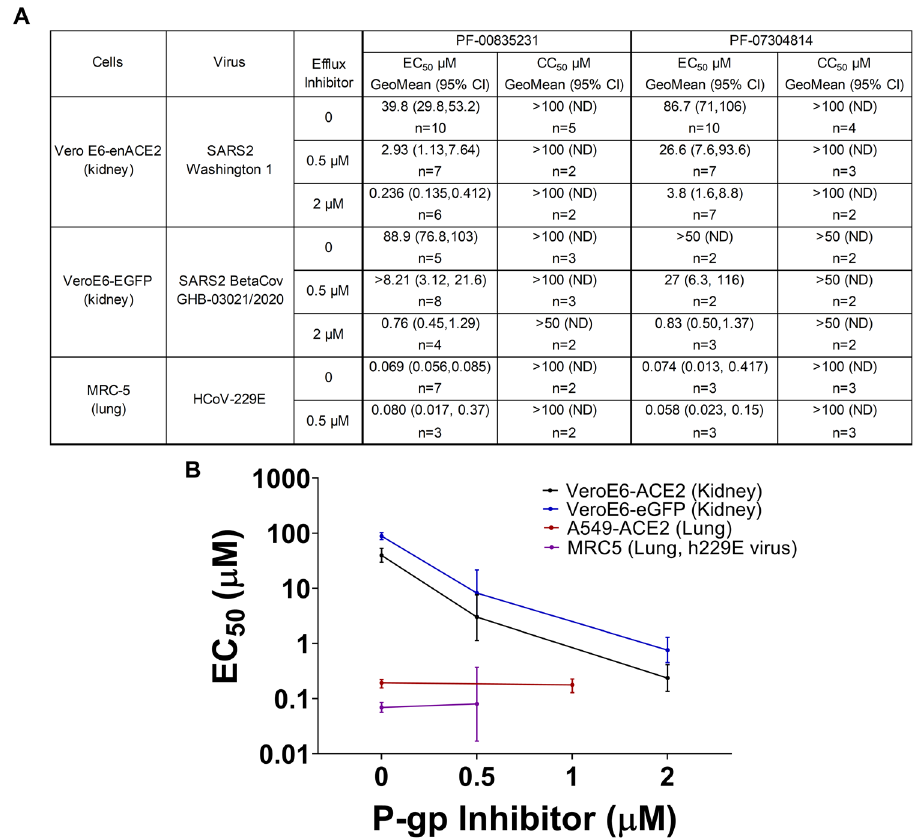
Fig. 2 Antiviral activity across cell lines and viruses. A In vitro antiviral activity (EC 50 ), and cytotoxicity (CC 50 ) for PF-00835231 and PF-07304814 with and without the P-gp ef fl ux inhibitor, CP-100356. n as shown re fl ects individual replicates ( B ) EC 50 values with PF-00835231 with increasing P-gp inhibitor in human lung and monkey kidney cell lines. A549-ACE2 human lung carcinoma data (red) as reported in ref. 18 . Data are presented as mean±95% con fi dence interval as error